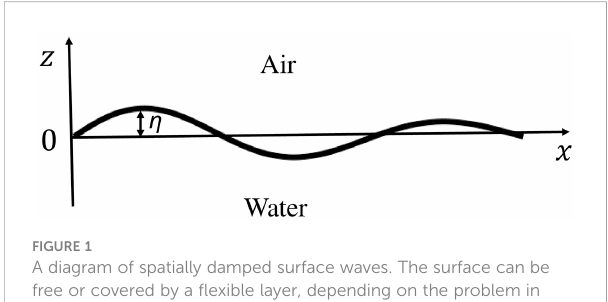
FIGURE 1 A diagram of spatially damped surface waves. The surface can be free or covered by a fl exible layer, depending on the problem in